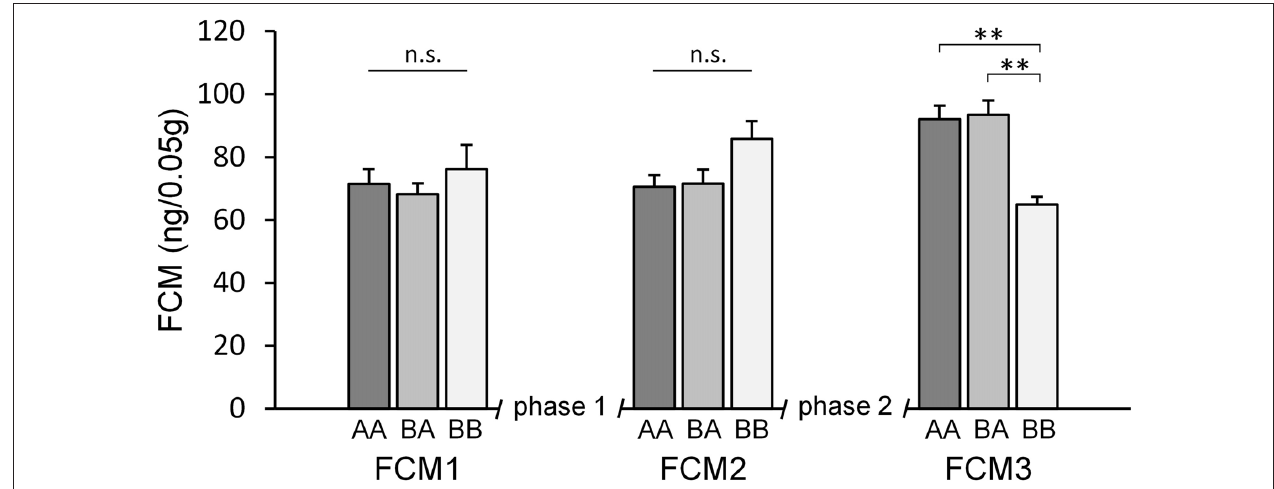
FIGURE 4 | Fecal corticosterone metabolites (FCM). Adult male mice were provided with two experimental phases (phase 1 and 2), during which they either experienced benefits followed by escapable adversity (BA group) or throughout adverse (AA) or beneficial conditions (BB), respectively. FCM concentrations were assessed before phase 1 (FCM1, PND 71), between phase 1 and 2 (FCM2, PND 100) and at the end of phase 2 (FCM3, PND 114). There was a significant effect of time as well as a significant interaction between time and experience. Data are presented as means + SEM. Statistics: repeated measures ANOVA; post hoc :